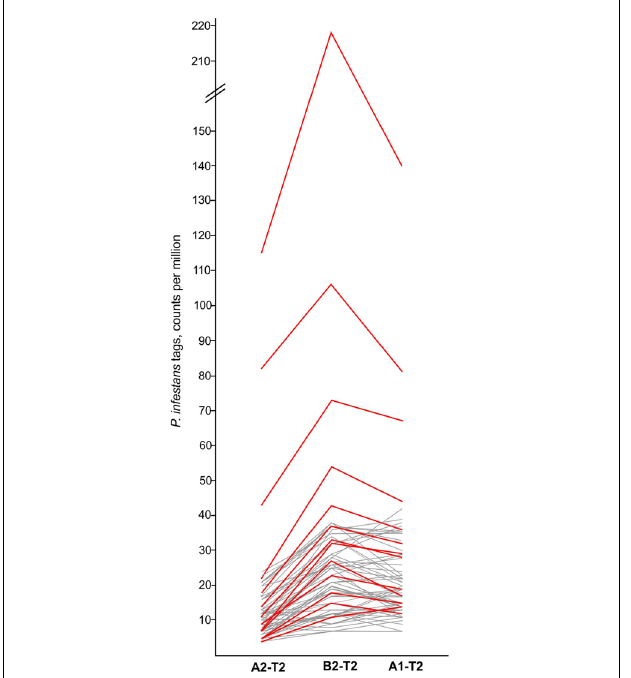
FIGURE 3 | Normalized tag counts (tpm) of 66 P. infestans tags up regulated in genotype pools A1, A2, and B2 2 days after infection (T2). A subset of tags showing typical expression patterns are highlighted red. For detailed tag counts see Supplementary Table S5